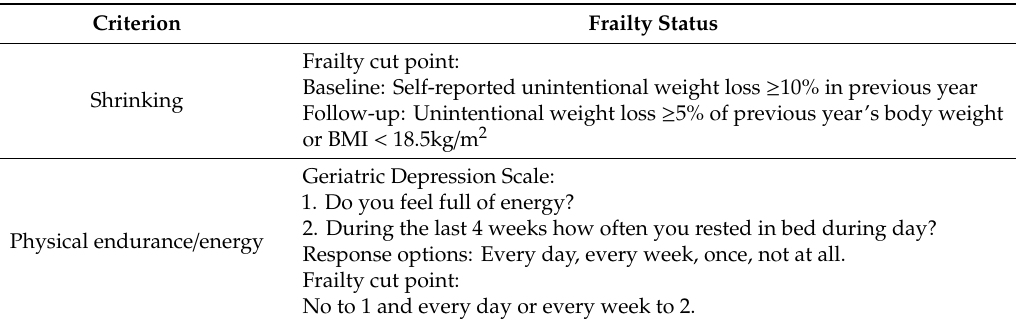
Table A4. Fried frailty index derived from Cardiovascular Health Study